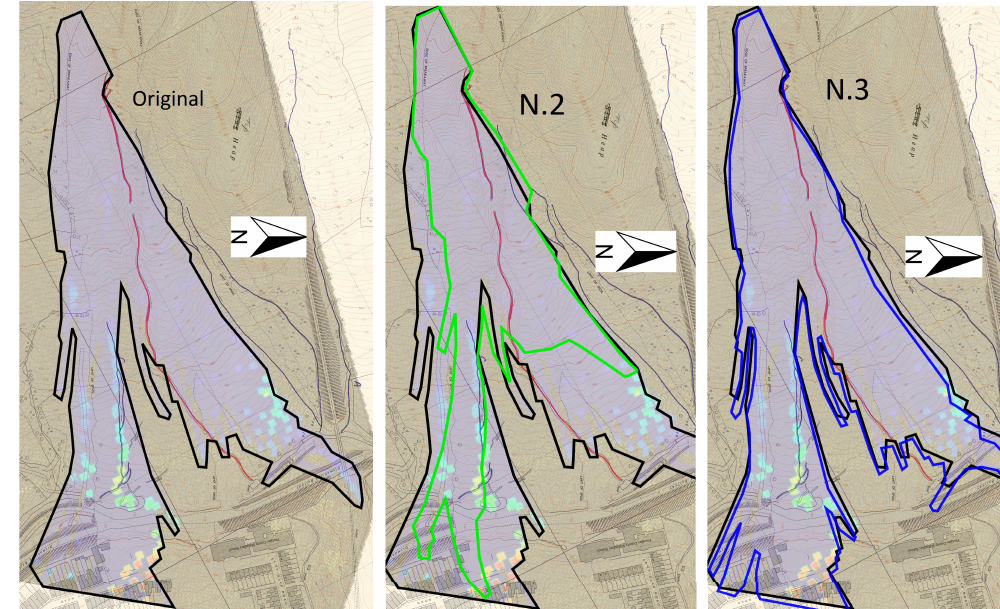
Figure 14. Propagation profiles: original ( left ), N.2 ( centre ) and N.3 ( right ).